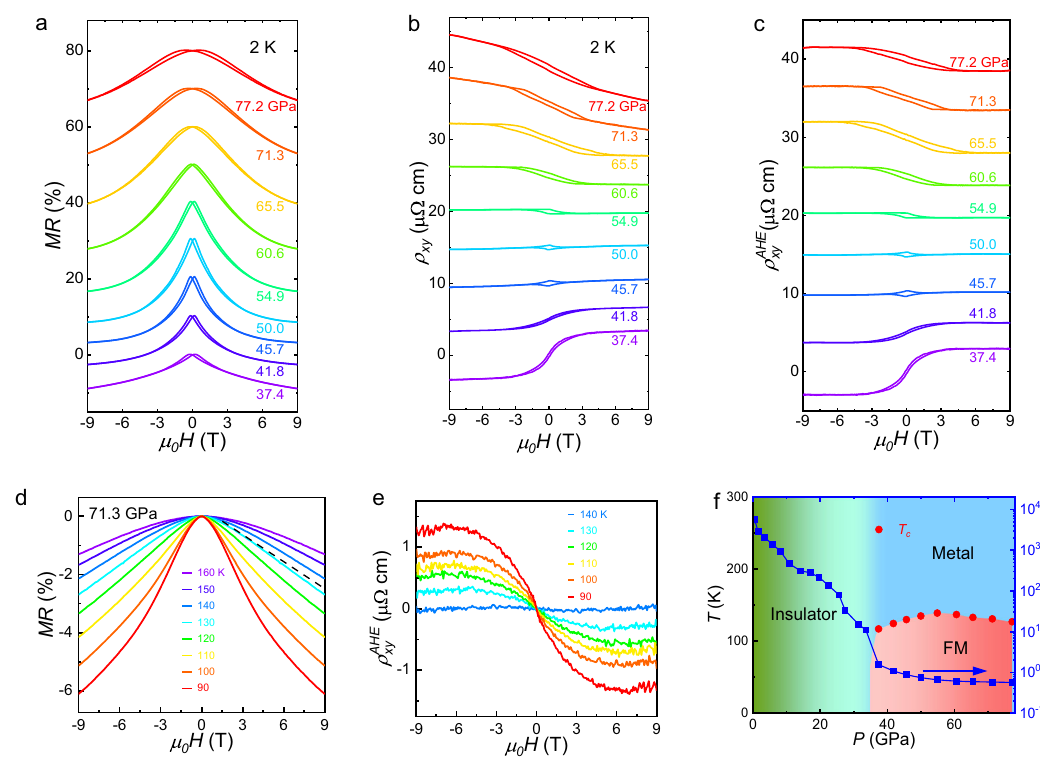
Fig. 2 | High-pressure phase diagram of La 2 O 3 Fe 2 Se 2 . a Pressure dependence of the magnetoresistance for pressurized La 2 O 3 Fe 2 Se 2 single crystal measured at 2K. b The Hall resistivity measured at 2K under various pressure. c The extracted anomalous Hall resistivity under various pressures. The MR d and Hall coef fi cient